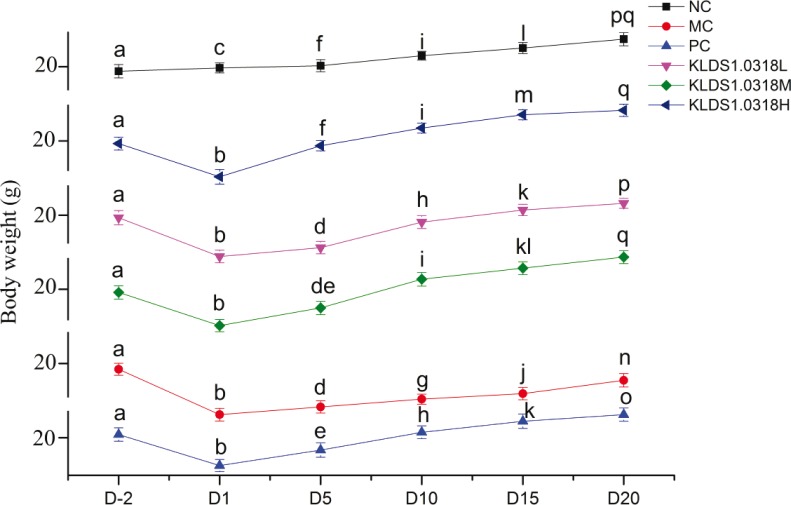
Changes of body weight in the six groups of mice. NC, non-immunosuppression + sterilized PBS; MC, immunosuppression (IM) + sterilized PBS; PC, IM + levamisole hydrochloride (40 mg/kg); KLDS1.0318-L, IM + 5 × 107 CFU/mL Lactobacillus plantarum KLDS1.0318; KLDS1.0318-M, IM + 5 × 108 CFU/mL L. plantarum KLDS1.0318; KLDS1.0318-H, IM + 5 × 109 CFU/mL L. plantarum KLDS1.0318. Data are expressed as the mean ± SD (n = 15). Different letters represent significant differences between groups in the same time point (p < 0.05). NC, normal control; PBS, phosphate-buffered saline; MC, model control; PC, positive control; CFU, colony-forming units.